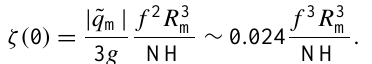
Fig. 7. Sea-level anomalies above meddies (cm) computed from AVISO altimetry (thin lines) and via expression (10) (thick lines) for meddies Hyperion (black lines), Encelade (dots and circles, dark grey lines), Pinball (triangles, dark grey lines), Ceres (squares, light grey lines) and Zoe (light grey lines). The buoyancy frequency was obtained from the climatic monthly mean density fields